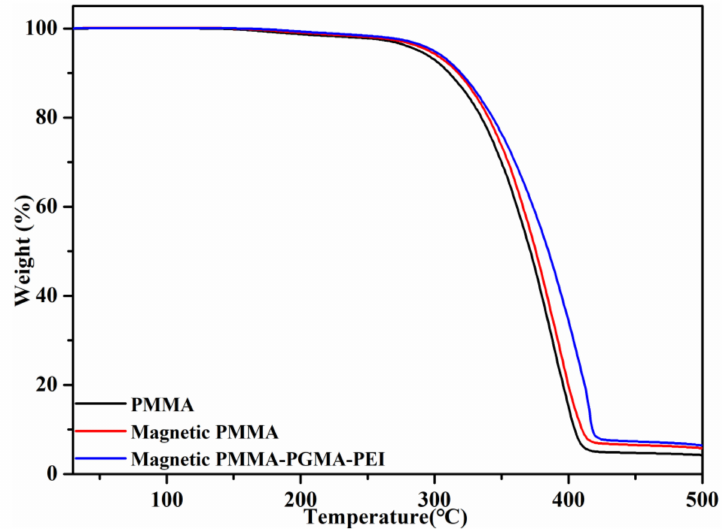
Figure 4. TG curves of PMMA, magnetic PMMA and magnetic